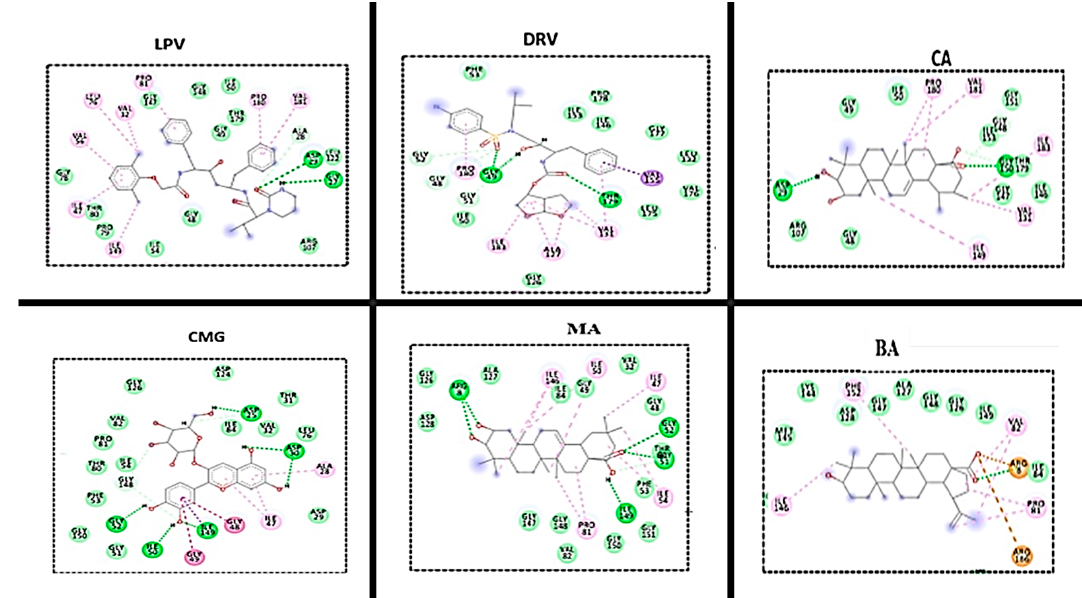
Figure 6. 2D interaction plots of two reference drugs (DRV and LPV) and plant metabolites (BA, MA, CA, and CMG) with the active site amino acid residues of HIVpro.